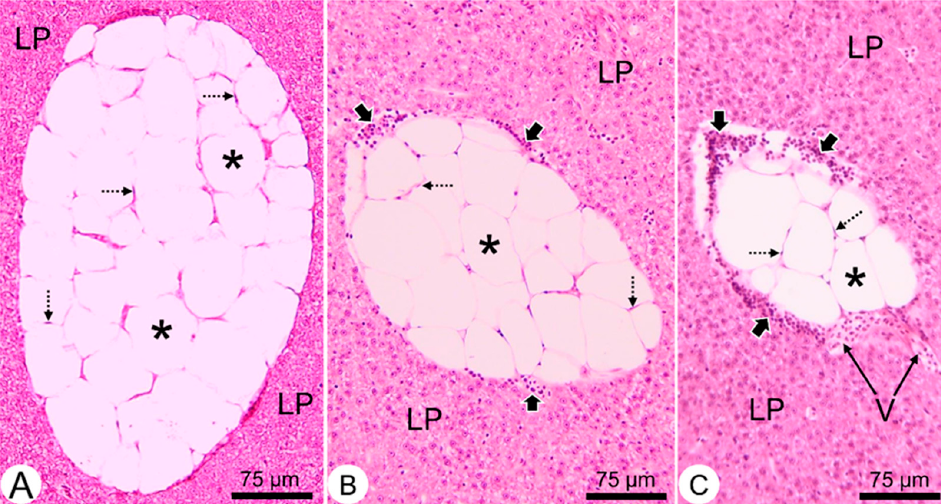
Figure 2. Representative histological sections ( A – C ) across the intrahepatic adipose cell agglomerate. There is a well-marked frontier between the adipocytes (*) and the liver parenchyma (LP). The flattened nuclei of the adipocytes are perceivable at the cell peripheries (dashed arrows). At specific locations around the adipose cell agglomerate, lymphocytic-like infiltrates are noted (block arrows) in the close vicinity of venules (V).